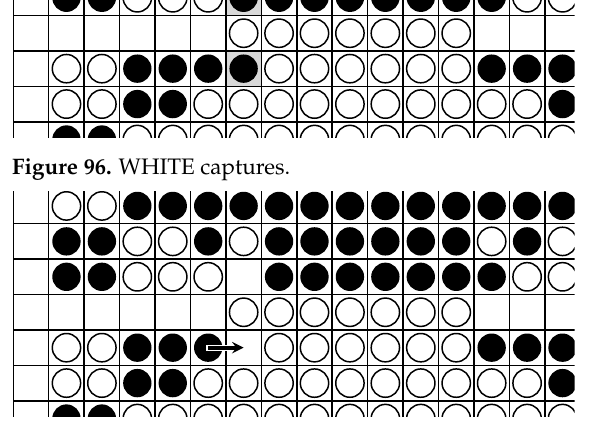
Figure 97. BLACK intrudes.